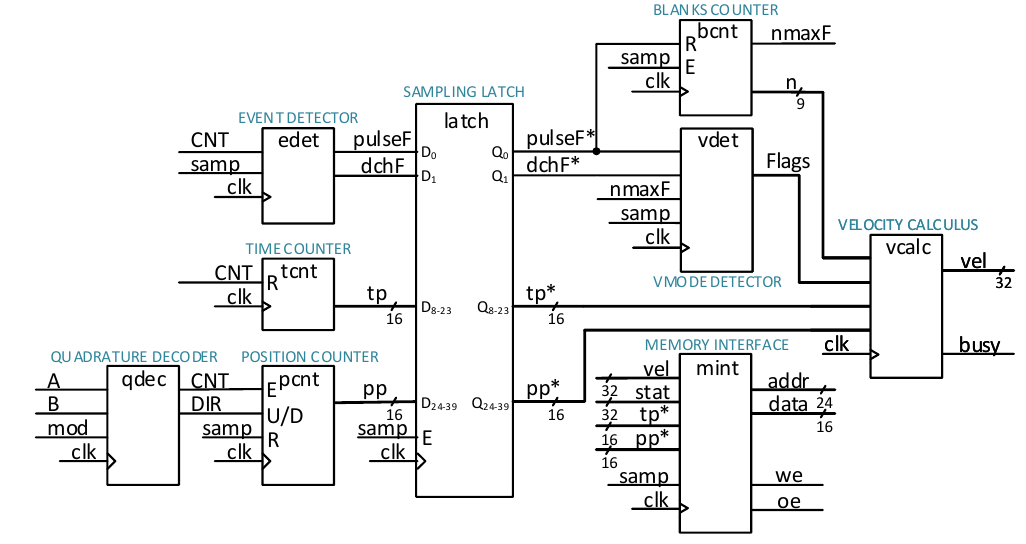
Figure 7. The block scheme of the velocity measurement system logic design on the FPGA.